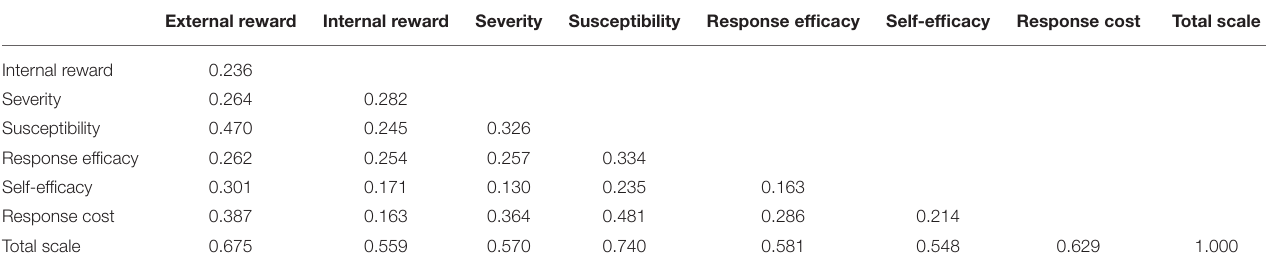
TABLE 8 | Correlation analysis of the scale.